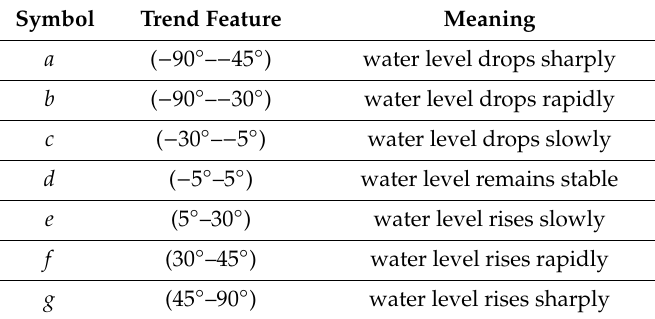
Table 2. The character sets and their meanings for the trend feature.